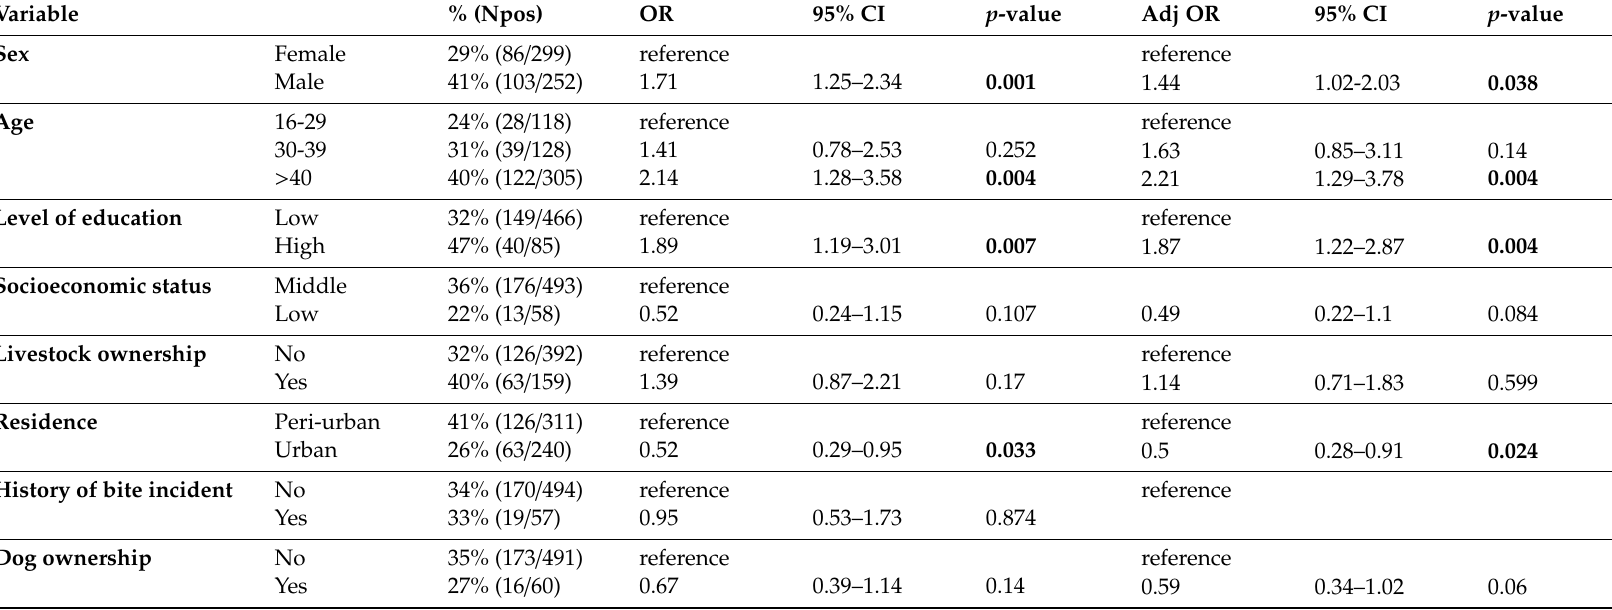
Table 3. Uni- and multivariable generalized estimating equation models for binomial outcome variables to determine respondent and household characteristics associated with rabies knowledge in Matadi, Democratic Republic of the Congo (DRC) in May